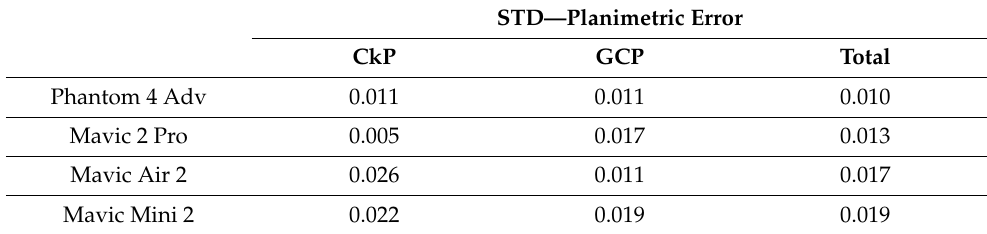
Table 10. Standard deviation calculated for the planimetric error.